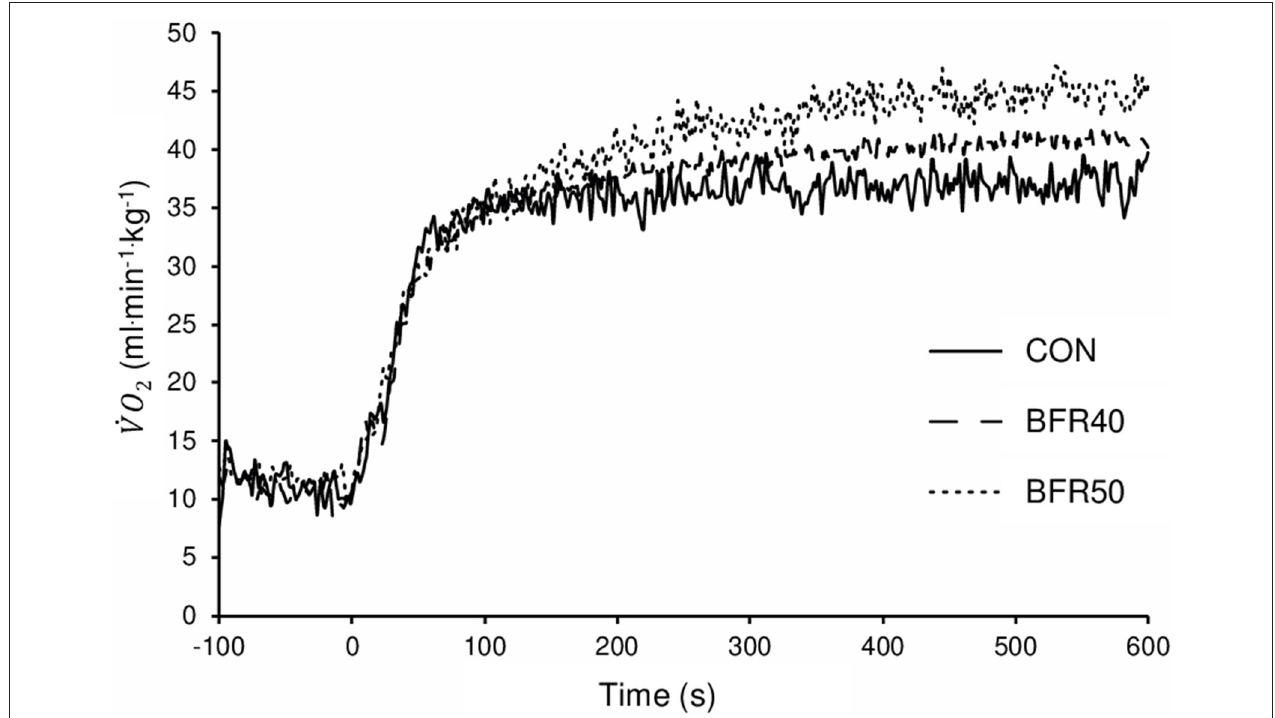
FIGURE 2 | Oxygen uptake for exercise without blood flow restriction (CON), with 40% (BFR40) or 50% (BFR50) occlusion for a representative subject.